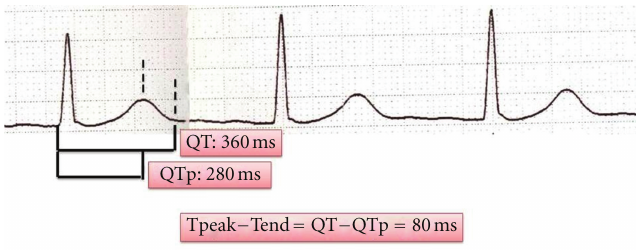
Figure 1: Measurement of P wave parameters on 12-lead surface